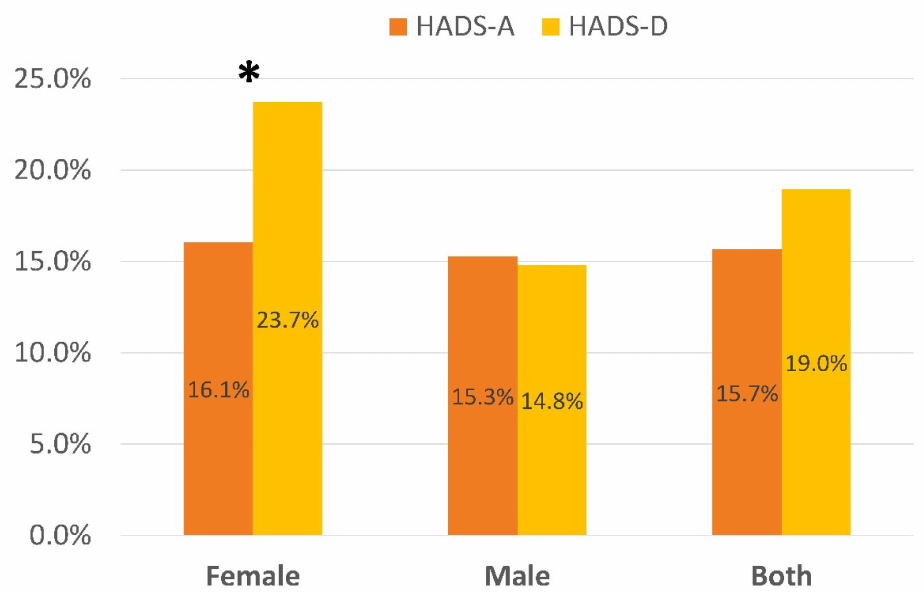
Figure 1. Distribution of the percentage of women and men exhibiting anxiety (HADS-A ≥ 8 points) and depressive (HADS-A ≥ 8 points) symptoms according to the Hospital Anxiety and Depression Scale (HADS) * Significant differences between female and male ( p < 0.01).